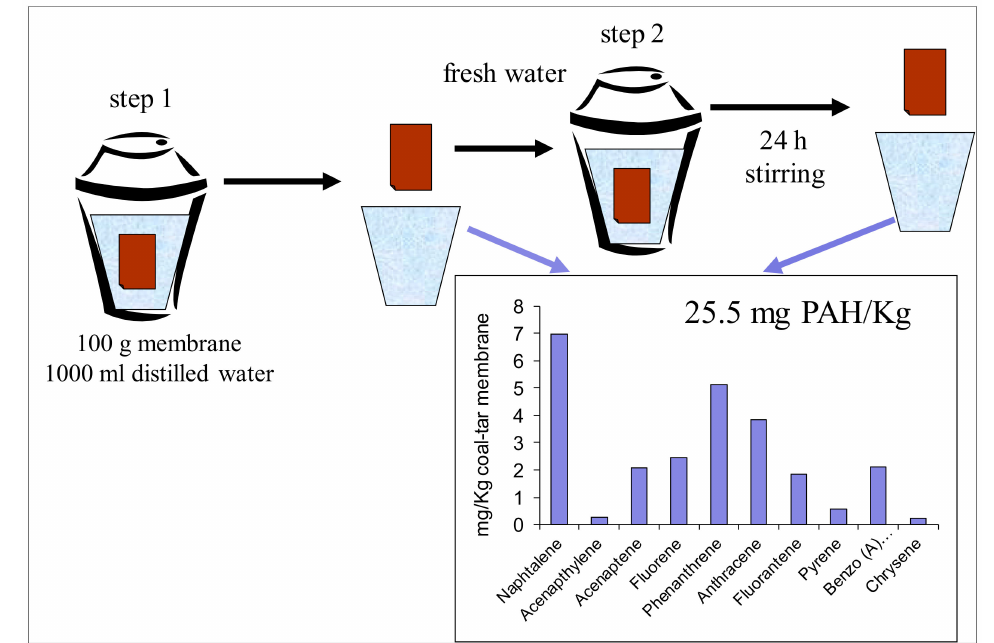
Figure 5. Schematic drawing of the experimental simulation of leaching of the contaminants from a coal-tar membrane in water and the obtained